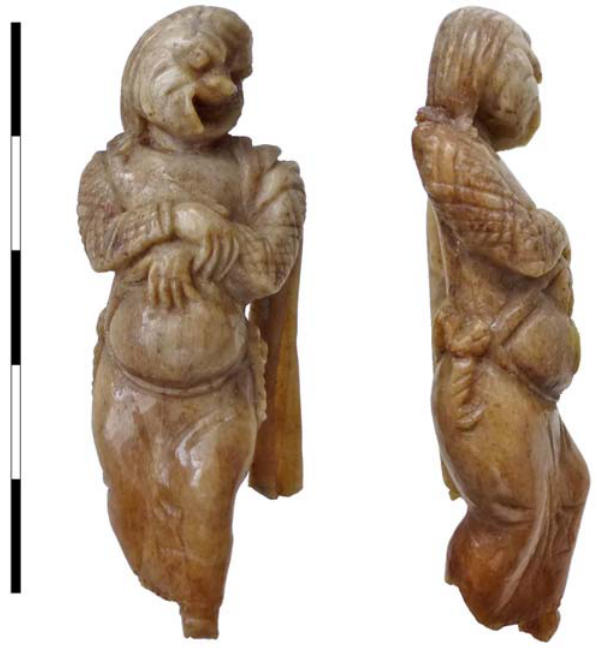
Figure 2: The fi gurine from I ž a - Leànyvàn. Front and left views. Scale subdivision, in centimetres ( Photo: Éva David )